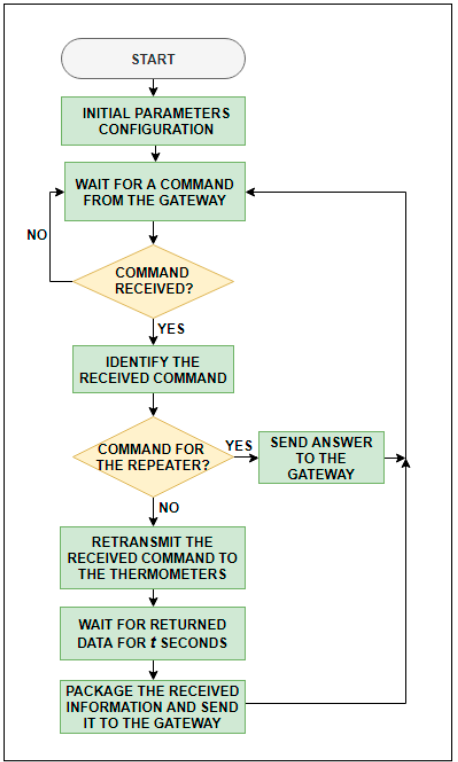
Figure 8. Repeater flow chart.